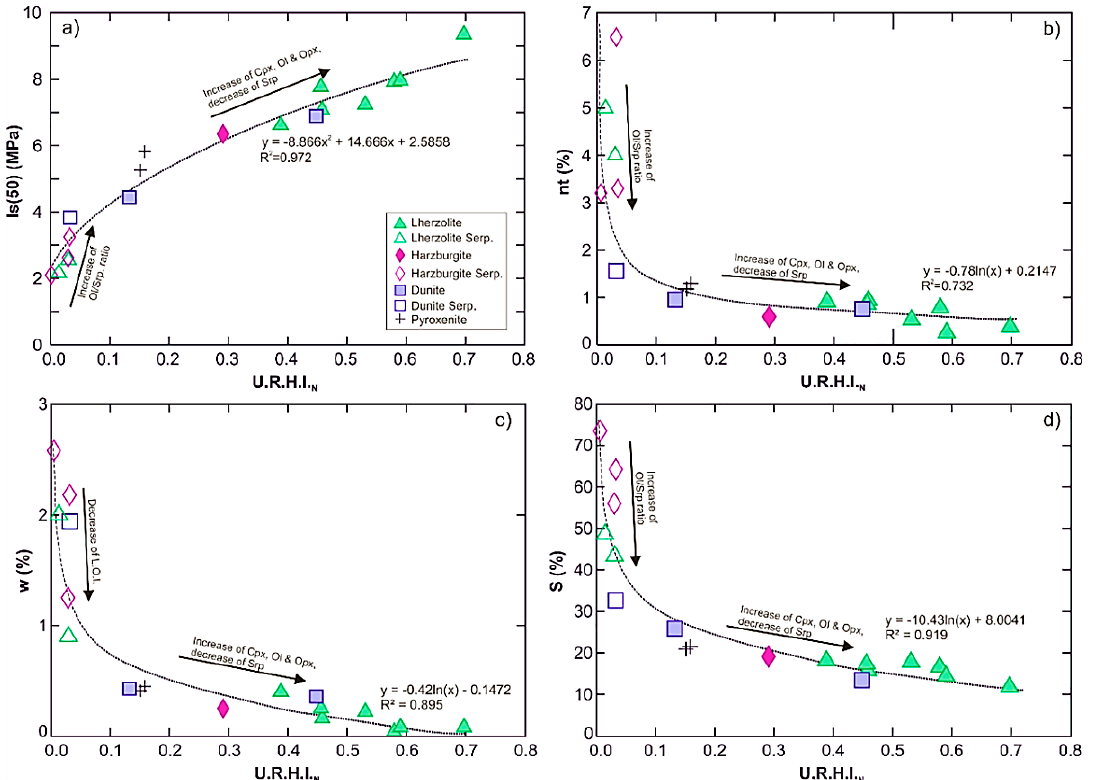
Figure 8. Correlation diagrams of ( a ) Is (50) (MPa) vs. U.R.C.I. N ; increasing LA values correspond to increasing primary mineral/serpentine (Srp) ratios. Negative correlations with U.R.C.I. N are noted for the ( b ) n t (%), ( c ) w (%) and ( d ) S (%). Primary minerals include orthopyroxene (Opx), clinopyroxene (Cpx) and olivine (Ol).